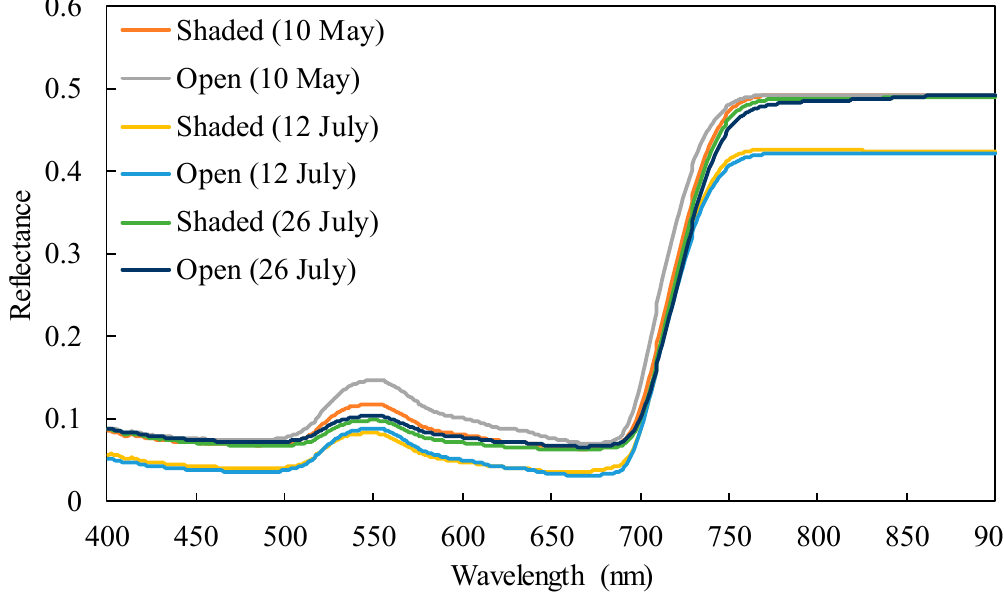
Figure 2. Mean reflectance spectra.